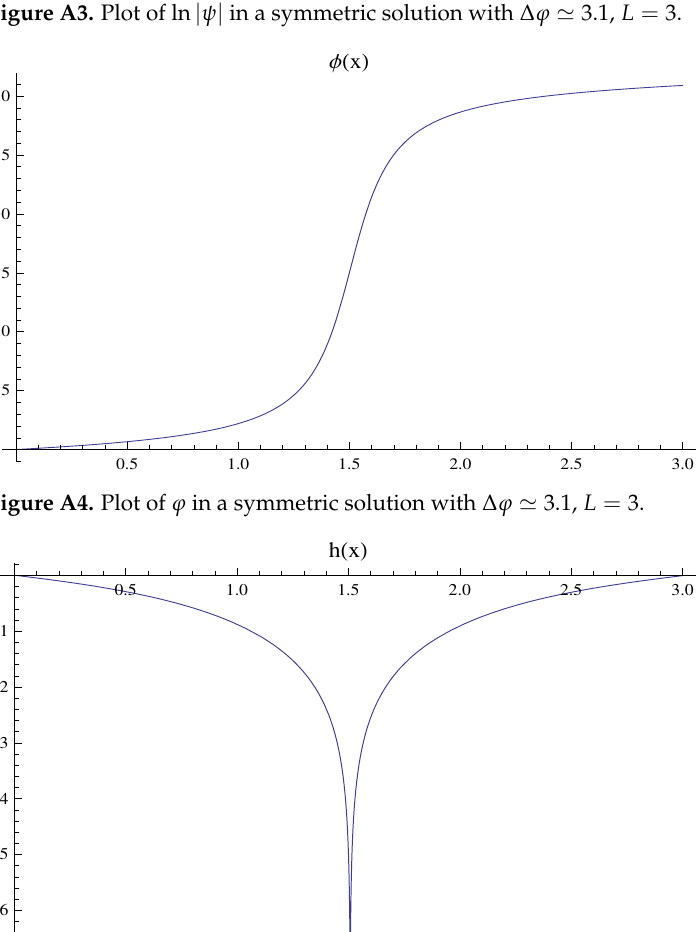
Figure A3. Plot of ln | ψ | in a symmetric solution with ∆ ϕ (cid:39) 3.1, L = 3.